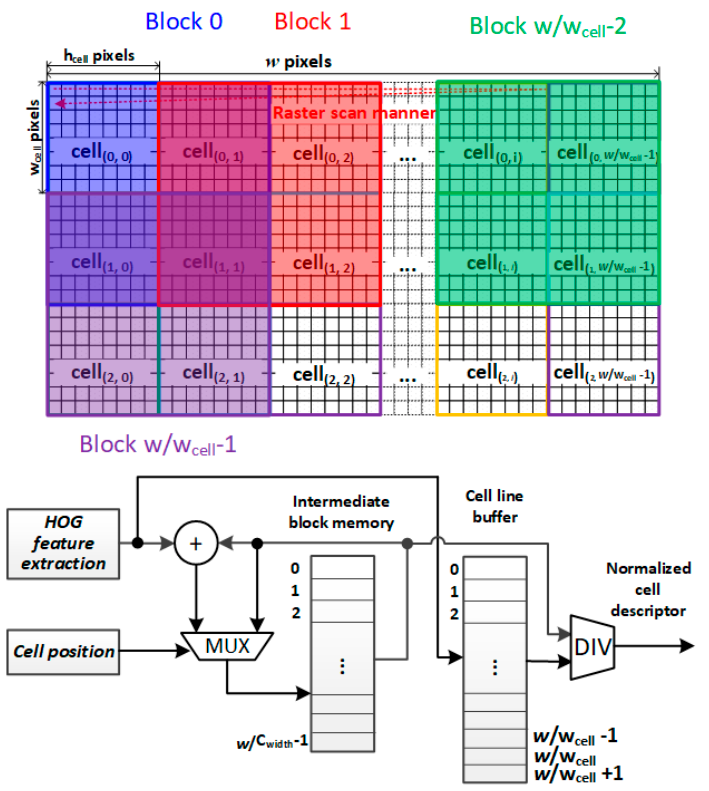
Figure 3. Block-level normalization. Cell position in a block and image is given by CRM.